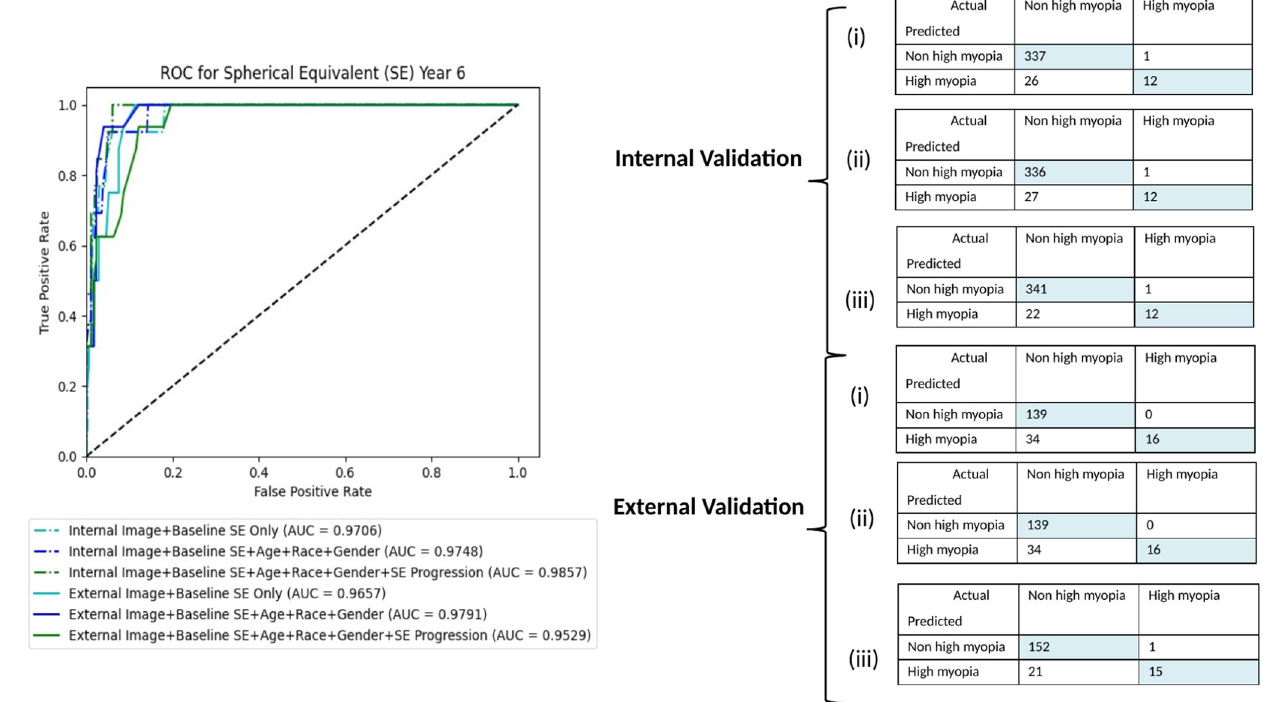
algorithm for image models, clinical models and mixed models